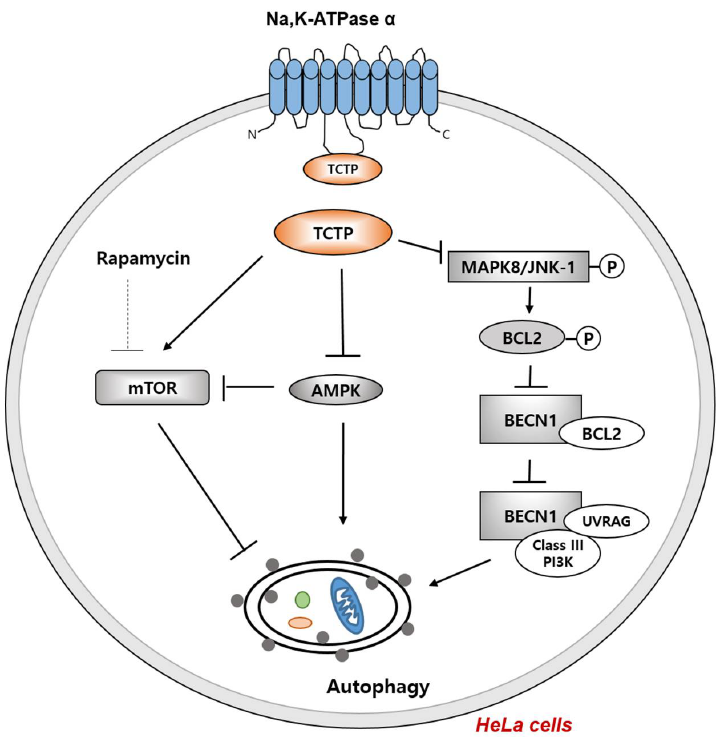
Figure 3. TCTP as a negative regulator of autophagy. TCTP negatively regulates AMPK, which leads to mTORC1 activation that promotes cell proliferation and inhibits autophagy in HeLa cells. TCTP also inhibits MAPK8–JNK1 which is known to phosphorylate and degrade BCL2. BCL2 forms a complex with BECN1 in the normal state, inhibiting autophagy. Once BCL2 is phosphorylated and degraded upon stress or starvation, BECN1 forms a complex with class III PI3K and UV radiation resistance-associated gene (UVRAG) and induces autophagy.